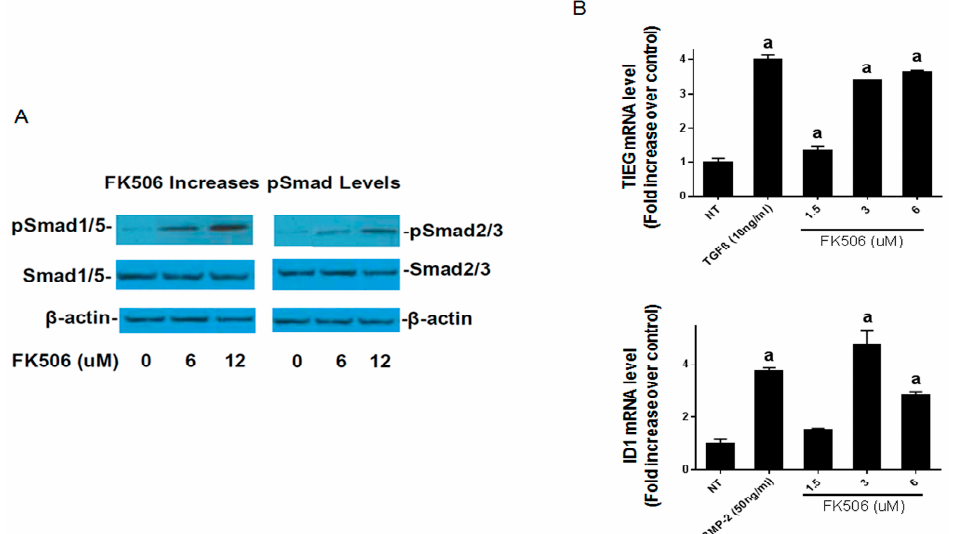
Figure 4. ( A ) FK506 increases BMP pSmad levels more than TGF- β pSmad levels. We treated C2C12 cells with FK506 (6 or 12 µ M) and measured pSmad levels by Western blot 1 h after treatment. FK506 treatment resulted in a greater activation of the BMP receptor pSmad1 / 5 compared with the TGF- β receptor pSmad2 at both doses. ( B ) FK506 is capable of activating the early response genes. In order to interrogate the dose response and relative activation of BMP versus TGF- β signaling, we measured mRNA expression of early response genes in each pathway by RT-PCR. The data demonstrate induction of mRNAs for early response genes for BMP and TGF- β ( Id1 and TIEG1 ) 1 h after exposure to Ligand (BMP-2 50 ng / mL or TGF- β 10 ng / mL) or FK506 in C2C12 cells. The 3 µ M dose of FK506 was capable of Id1 or TIEG1 induction comparable to that of 100 ng / mL of BMP-2, but higher FK506 doses may preferentially induce signals that decrease BMP pathway activation, such as TGF- β . Statistical significance for a denotes comparison to the no-treatment